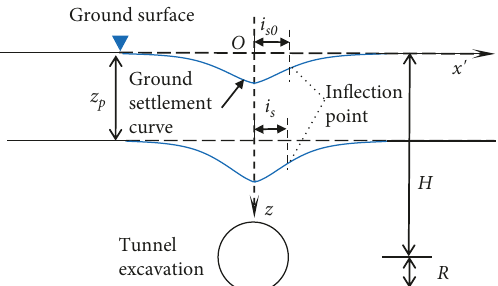
Figure 1: Soil settlement caused by tunnel